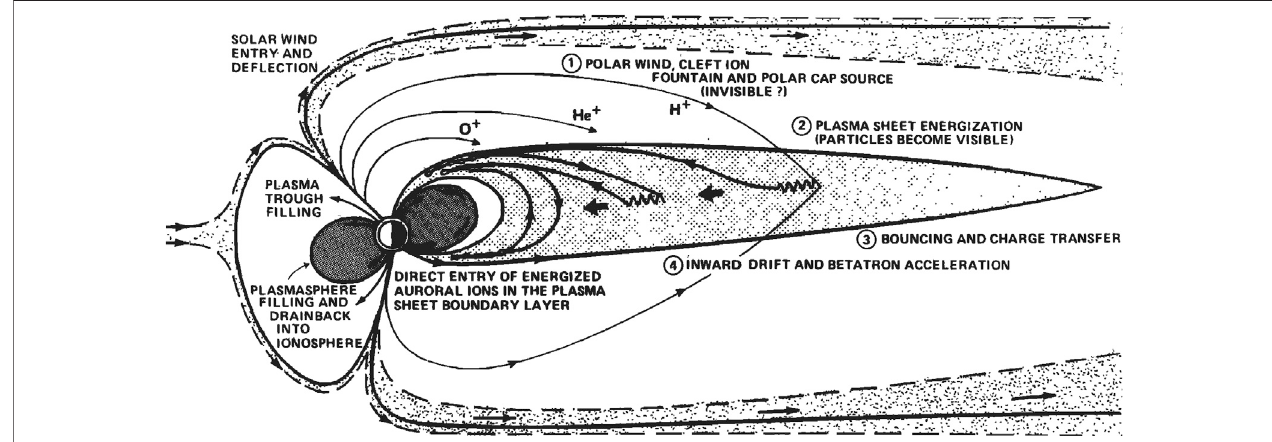
FIGURE 2 | A schematic look at the process by which the Earth ’ s ionosphere might supply plasma to the different regions of the magnetosphere (Chappell et al., 1987).